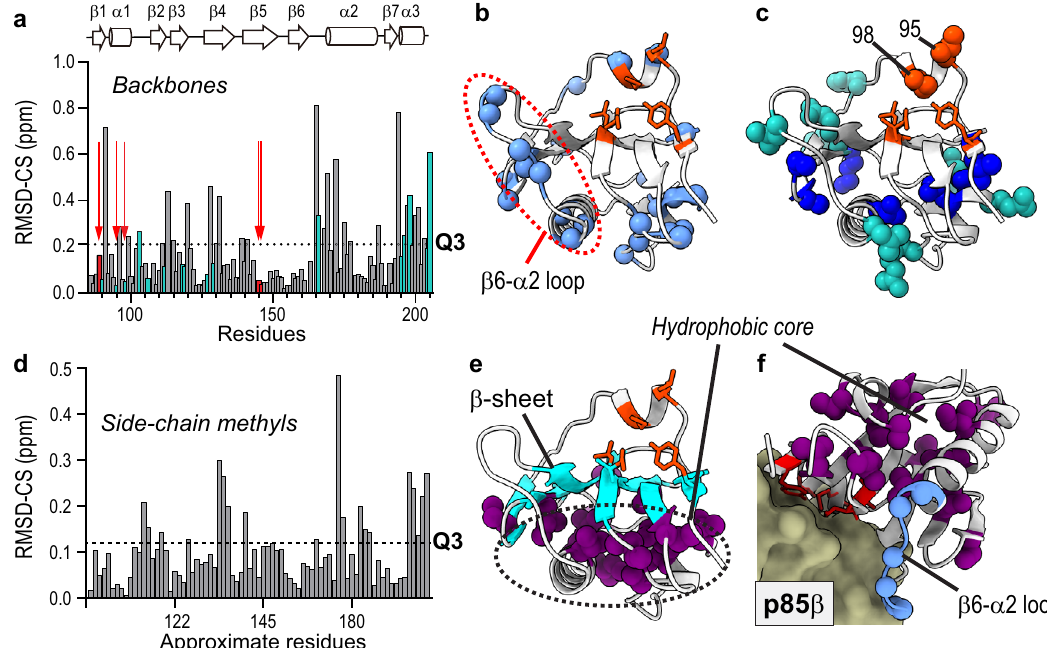
Fig. 5 | Conformational variation across NS1s. a RMSD-CS of backbone amides ( 15 NH) resonances of NS1s ( n =3 or 4). Green bars correspond to strain-speci fi c mutational sites. Dotted line represents Q3. Orange arrows show positions of core interface residues. b Residues whose RMSD-CS ( 15 NH)>Q3 are shown as light blue spheres. Core interface residues are shown as orange sticks. c Strain-spe c i fi c mutationsitesareshownasspheres.Mutationsinthehydrophobiccoreareshown in blue spheres. d RMSD-CS of methyl ( 13 CH 3 ) resonances of NS1s. Note that x -axis